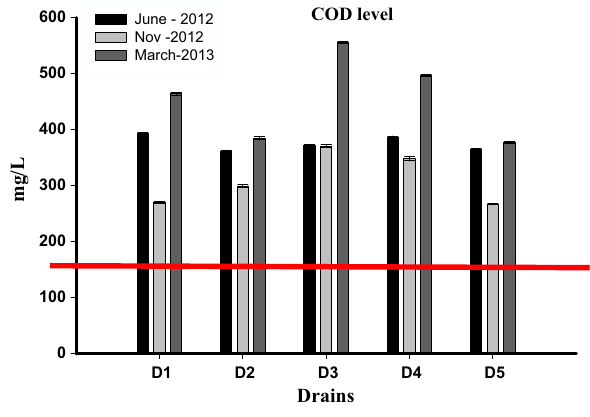
Fig. 1 COD level of different drains of HIE, Red line shows the NEQS